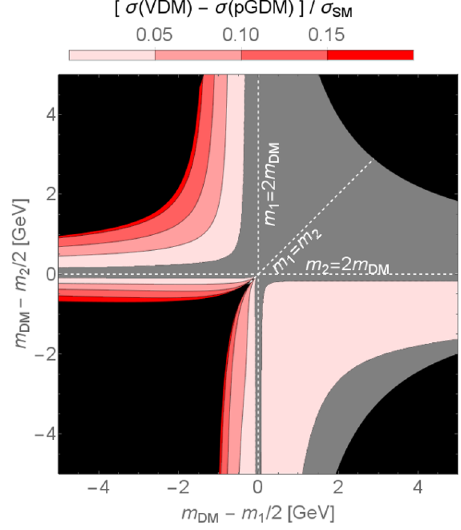
Figure 12 . The di(cid:11)erence between predictions for the pGDM and the VDM. The gray region denotes parameter space for which the di(cid:11)erence is smaller than the limit of (cid:12)gure 8. The models are compared in the region where both of them are consistent with the data, see (cid:12)gure 11.